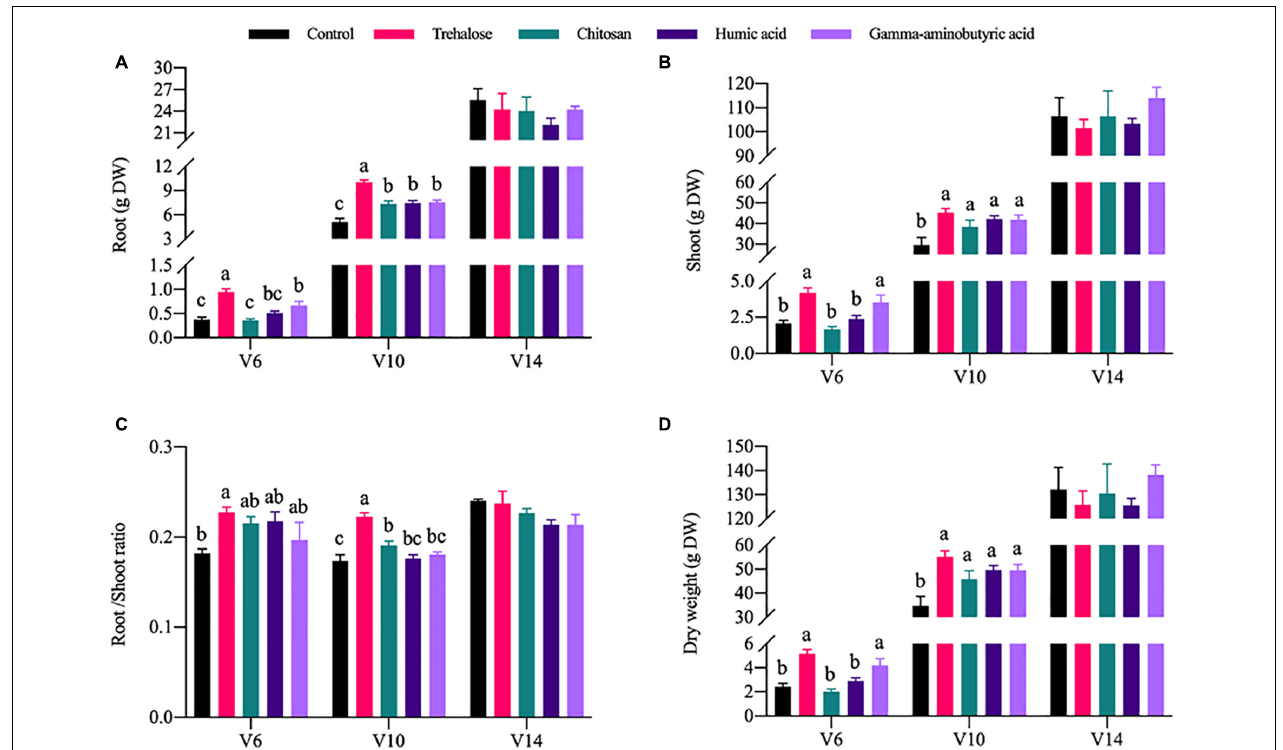
FIGURE 1 | Effects of PGRs on maize growth at different growth stages. Comparisons were made between PGRs treatments with different colors in the same growth period; significant differences are indicated by different lowercase letters in the same figure panel, and no letter indicates no significant difference ( P < 0.05, n = 5). V6, V10, and V14 represent the 6-, 10-, and 14-leaf stages of vegetative growth, respectively. DW, dry weight of the plant. (A) Root. (B) Shoot. (C) Root/shoot ratio. (D) Dry